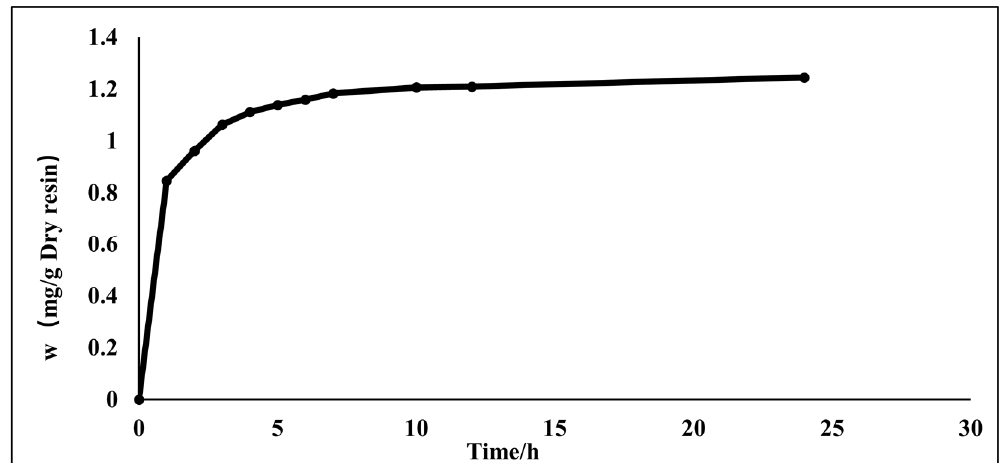
Figure 5. Static adsorption kinetics.